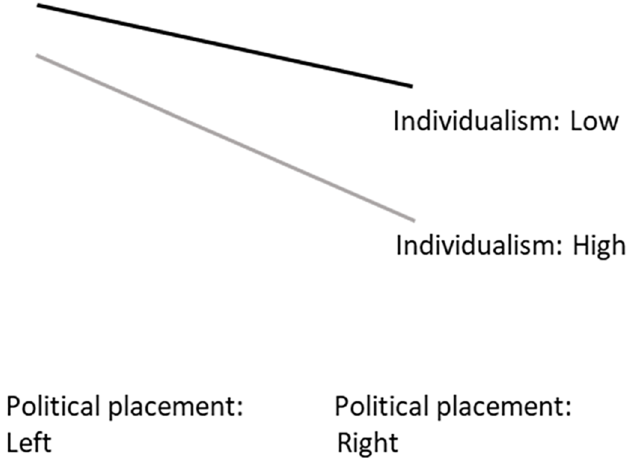
Figure 1. The association of political placement and the state’s welfare responsibility on the low and high levels of individualism.